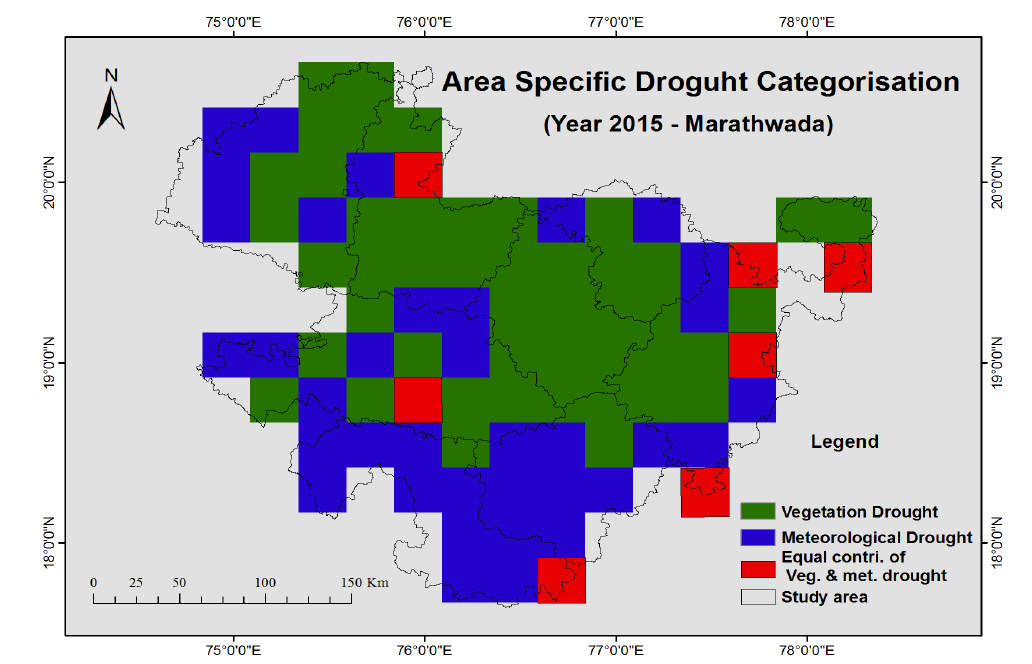
Figure 9. Area-specific categorization of Agro-climatological drought